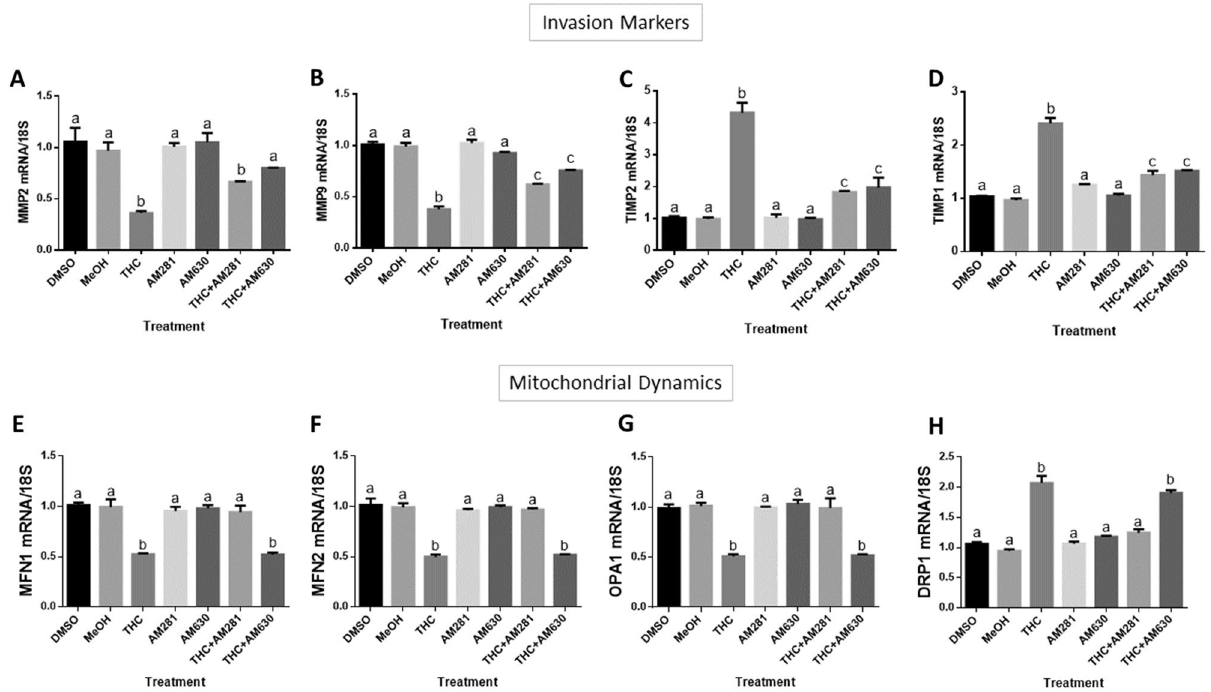
Figure 5. CBR-THC binding reduces invasive potential and disturbs mitochondrial dynamics in HTR8/SVneo cells. HTR8/SVneo cells were treated for 48 h as described in “Methods”, with DMSO and methanol (MeOH) used as vehicle controls. Summary histograms of relative MMP2 (A) , MMP9 (B) , TIMP2 (C) , TIMP1 (D) MFN1 (E) , MFN2 (F) , OPA1 (G) and DRP1 (H) transcript expression in each treatment group normalized to 18S, then compared to the gene in the vehicle controls. Significant differences were determined by a one-way ANOVA, followed by a Bonferroni post hoc test. Data are presented as means ± SEM (n = 3). Different letters denote significant differences compared to vehicle controls ( A–H , P < 0.0001). THC: 20 µM; AM281: 1 µM; AM630: 1